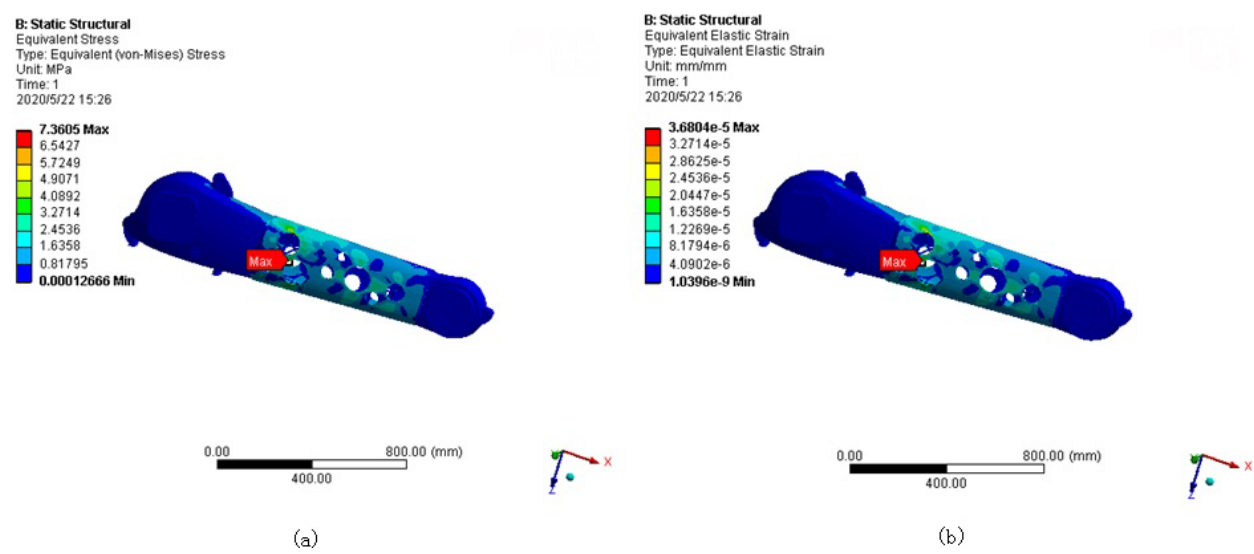
Figure 15. Static cloud map after robot forearm optimization: (a) stress cloud map after optimization; (b) model displacement cloud map after